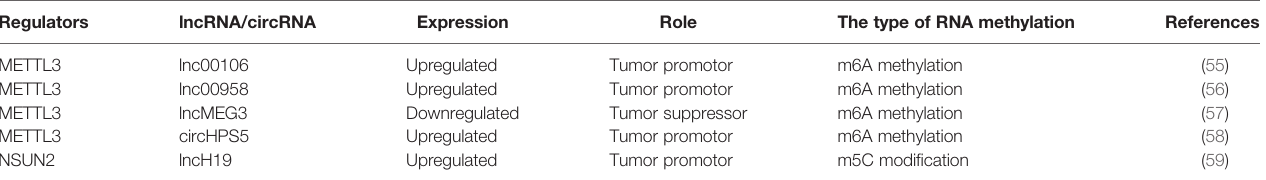
TABLE 3 | The expression, RNA methylation regulators and the type of RNA methylation of lncRNAs/circRNAs in HCC.